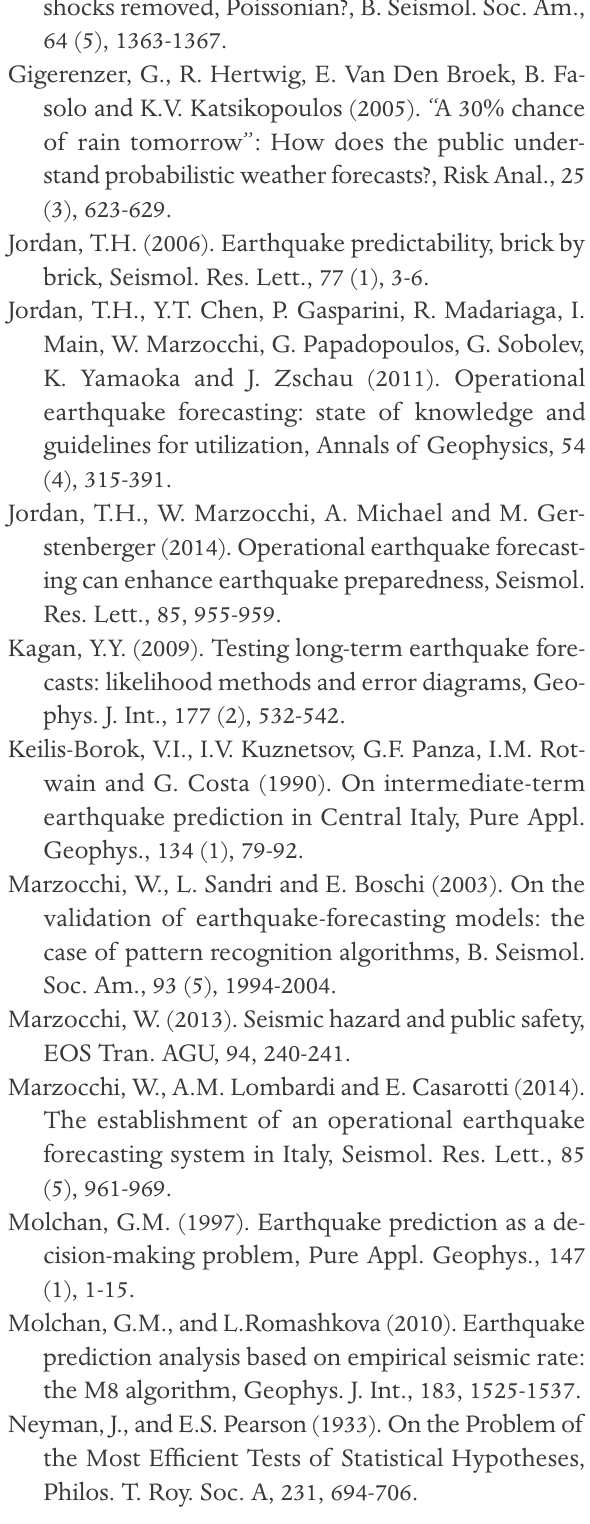
Table 3. Molchan test results.